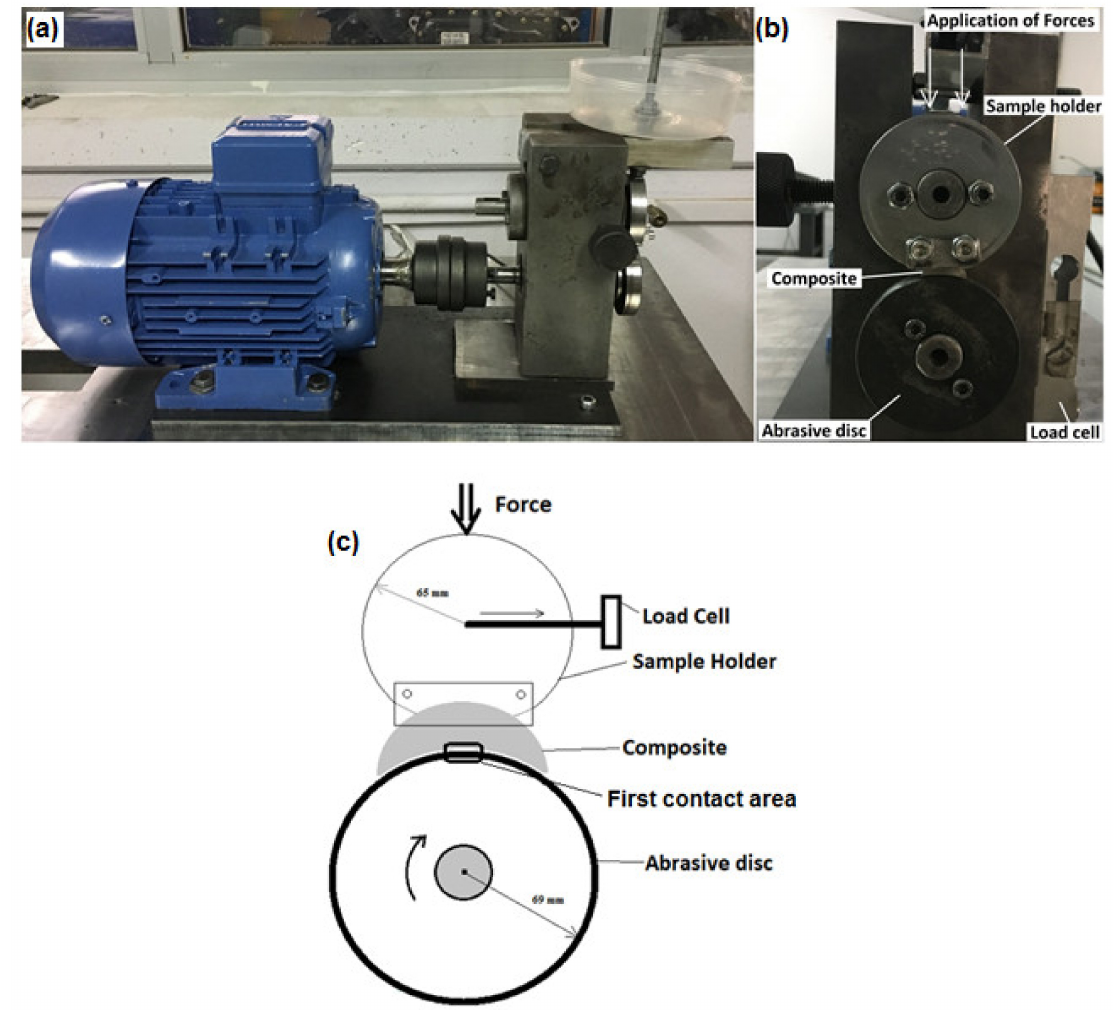
Figure 3. Wear test setup: ( a ) side view ( b ) front view and ( c ) schematic